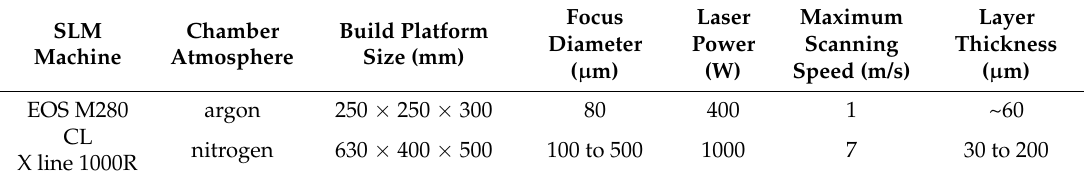
Table 3. Selective laser melting (SLM) process parameters as reported by manufacturers [27,28]. SLM